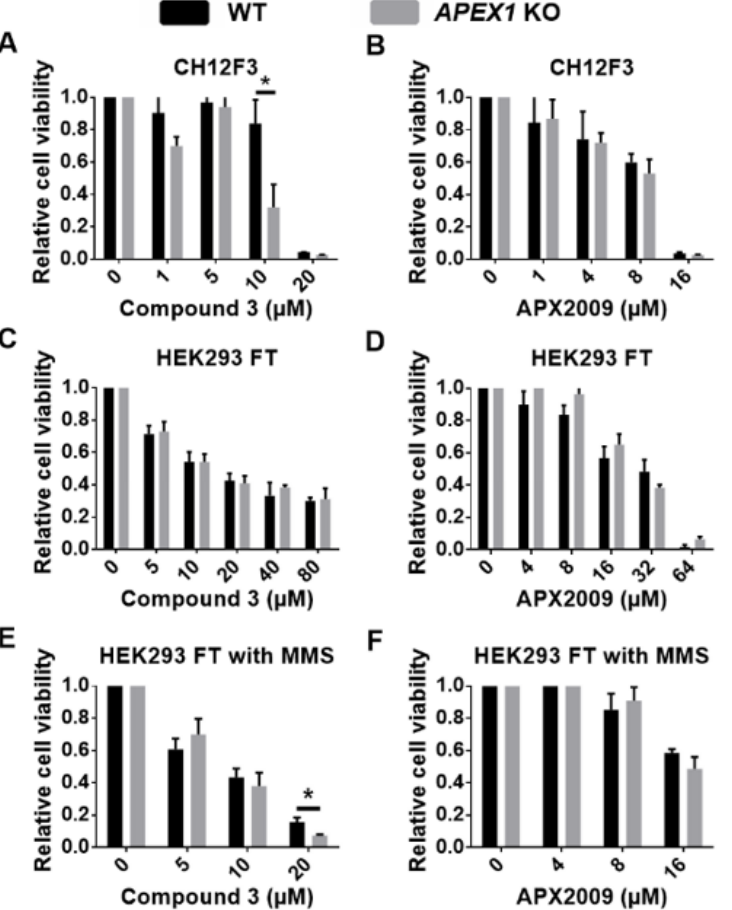
Figure 2. Direct cell killing and off-target effects of Compound 3 or APX2009. CH12F3 APEX1 + cells and APEX1 -KO cells were treated for 24 h with the indicated amounts of Compound 3 ( A ) or APX2009 ( B ). HEK293 FT cells were treated with compound 3 ( C ) or APX2009 ( D ) alone or combined with 0.2 mM MMS ( E , F ). Cell viability was determined using the MTT assay. * p < 0.01. Data are presented as mean ± SD, with n = 4 per group, and analyzed by Student t -test.